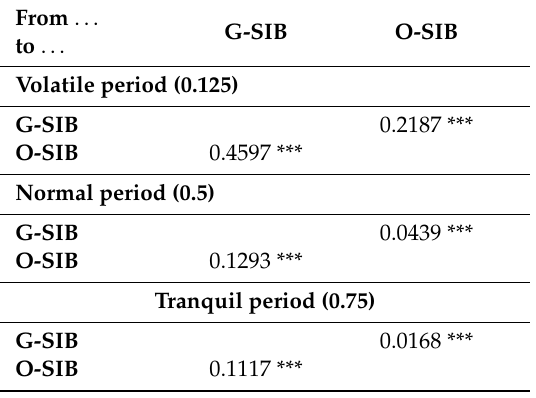
Table 9. Spillover coe ffi cients of the SDSVaR model, based on systemic importance of the banks. From ... to ...